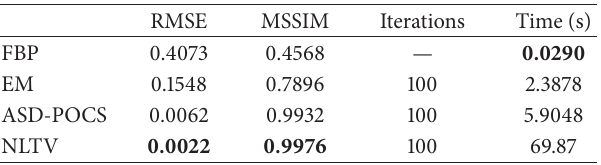
Table 1: Evaluations of numerical phantom